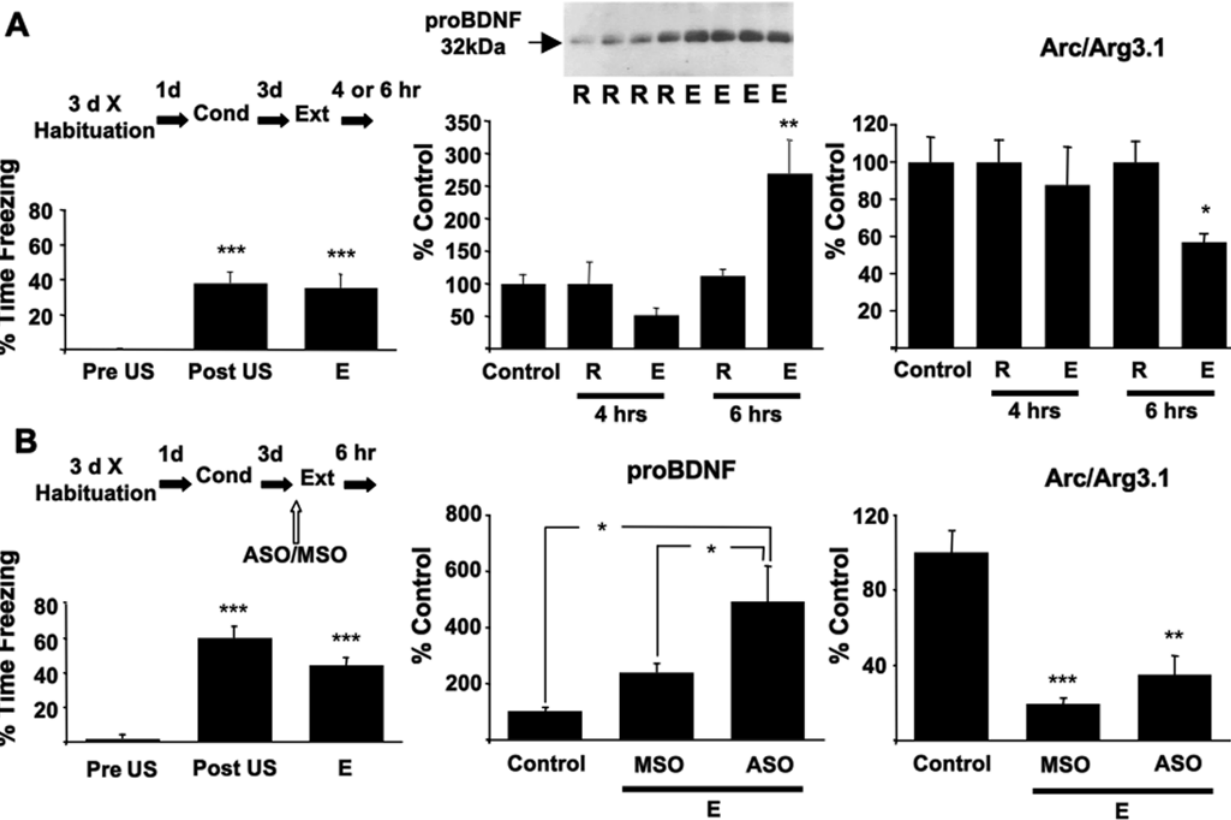
Figure 4. Extinction training-induced changes in proBDNF and Arc/Arg3.1 protein in the CA1 of hippocampus. ( a ) Rats showed robust conditioned freezing during the first two min re-exposure to the training context (E) 3d after a single fear conditioning trial (C). n=20 at C, and n=16 at E. Following recall there was a change in proBDNF in the CA1 (F (4,14) =8.961, P =0.000, ANOVA). ProBDNF levels more than doubled in CA1 6 hrs after a 10 min exposure to the conditioned context (E). No changes were seen after a 2 min exposure to the fear-conditioned context (R). Arc/Arg3.1 protein in CA1 decreased 6 hrs after a 10 min exposure (E) but not following a 2 min exposure (R) to the conditioned context. ( b ) High levels of conditioned freezing were seen in rats administered intrahippocampal infusions of ASO and MSO 90 min before extinction training. There was no difference in the levels of freezing between the ASO and MSO administered rats at E (F (1, 7) =4.202, P =0.080, ANOVA). However, proBDNF levels in CA1 were altered after extinction (F (2, 9) =6.974, P =0.015, ANOVA) and were greater in the ASO administered when compared to control and MSO administered rats 6 hours after extinction. In the same rats, protein levels of Arc/Arg3.1 were also regulated in CA1 (F (2, 9) =23.742, P . 0.000, ANOVA), but were decreased in both MSO and ASO groups. Rats in the control group were fear conditioned at C, but were killed 3 d later. n=4 for all groups in Western blot measurements. Results are the Mean 6 S.E.M. * P , 0.05, ** P , 0.01, *** P , 0.001 compared to control unless otherwise marked.